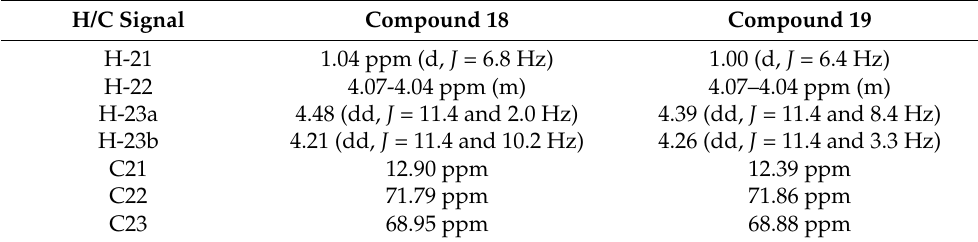
Table 2. Comparison between signals of 1 H (400.1 MHz, CDCl 3 ) and 13 C (100.6 MHz, CDCl 3 ) NMR for H/C21, H/C22 and H/C23a-b, for the diasteroisomers 18 and 19